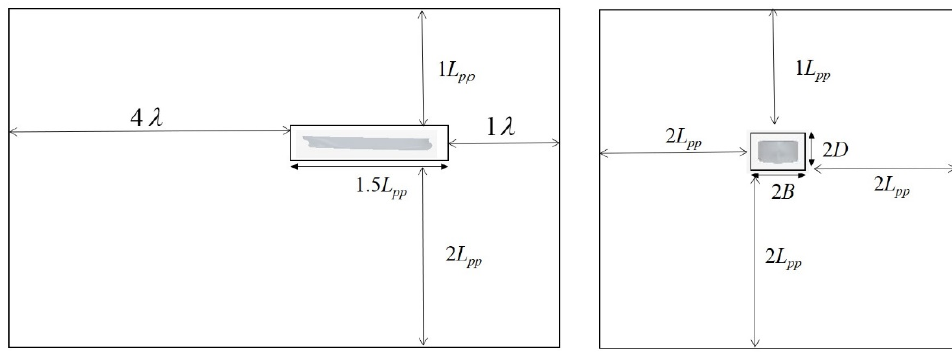
6 of 19 Figure 5. Coordinate system and 3D numerical wave tank.